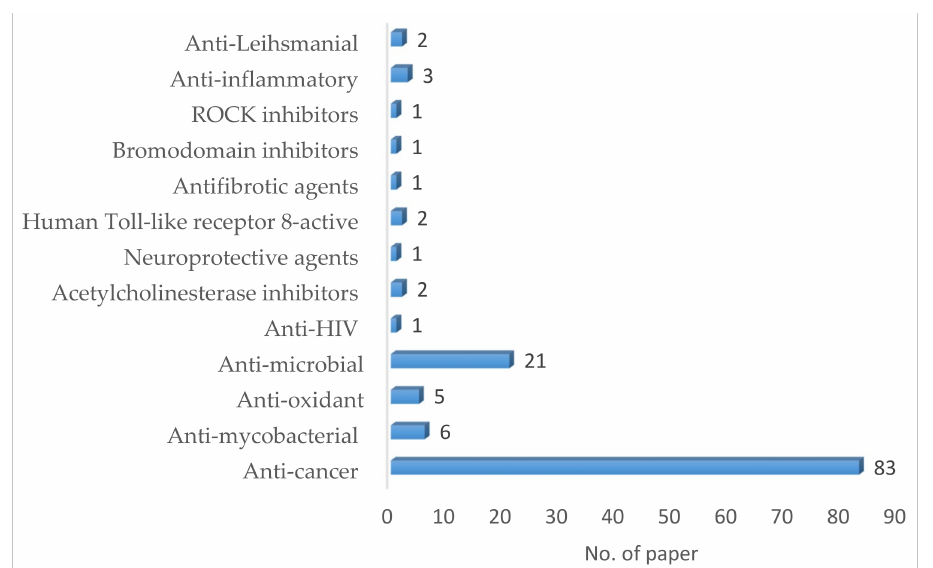
Figure 1. Bibliometric graphic depicting the number of published research papers vs the type of biological activity screened [Data were collected searching for the keywords “multicomponent reactions” and “biologically active molecules” by the period 2002 to